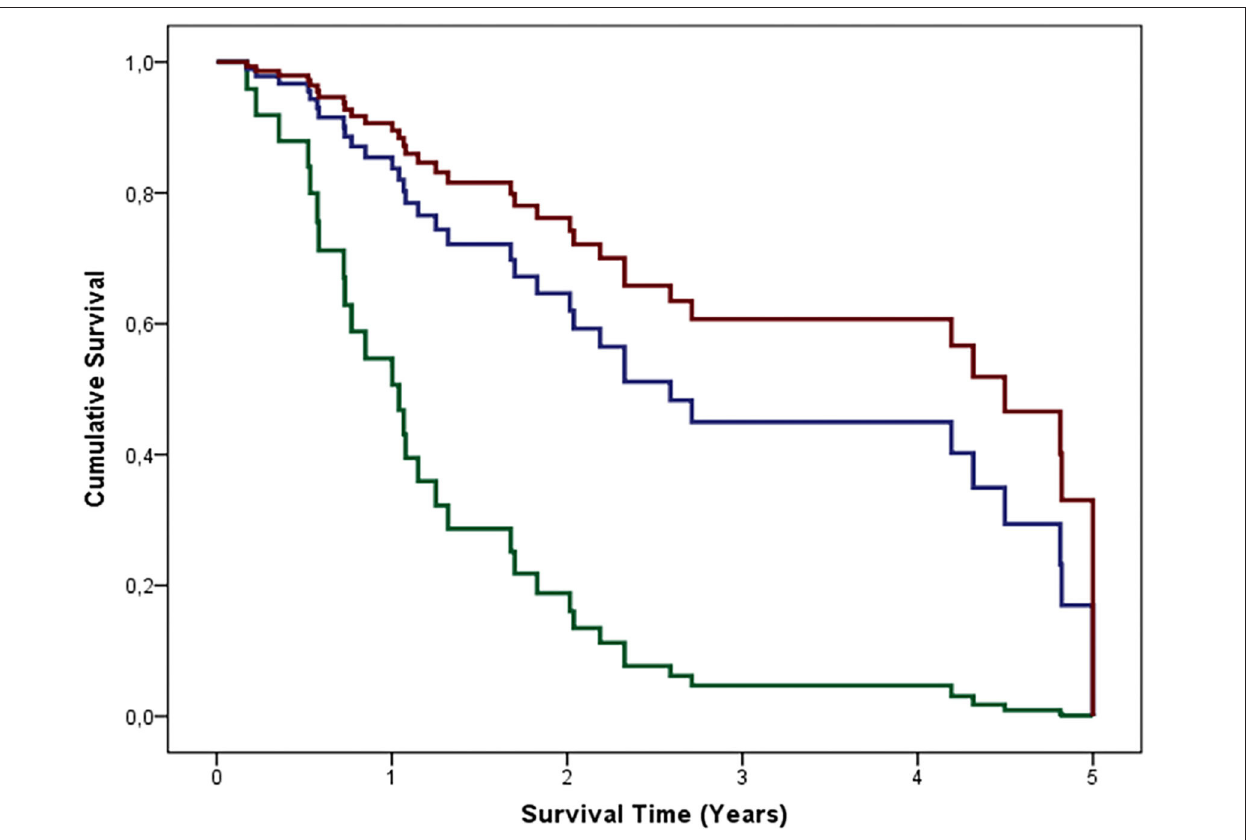
FIGURE 2 | Cumulative survival of 50 ALS patients grouped according to their γ ’ values. Group 1 or reference group (green line): γ ’ fibrinogen < 30 mg/dL; group 2 (blue line): γ ’ fibrinogen 30–60 mg/dL; group 3 (red line): γ ’ fibrinogen > 60 mg/dL. The depicted curves are based on the mean of the independent variables (gender, age, FTD, spinal and/or bulbar onset, diagnosis delay, and the aforementioned γ ’ fibrinogen-related groups; Supplementary Table 5A ).